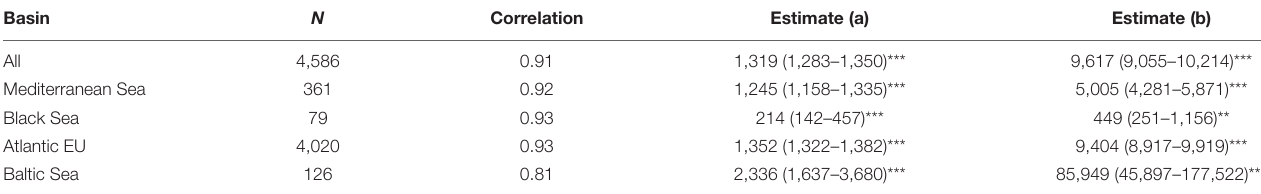
TABLE 1 | Results of the non-liner regressions for all basins and for each individual basin. Basin N Correlation Estimate (a) Estimate (b) All